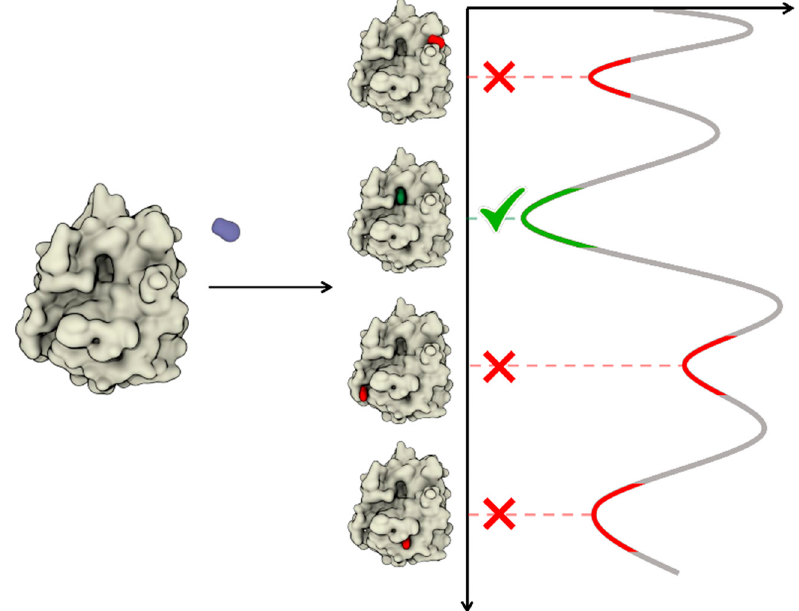
Figure 5. Schematic representation of unbiased MD approaches to dynamic docking. The most populated state should, in principle, correspond to the energetic minimum.